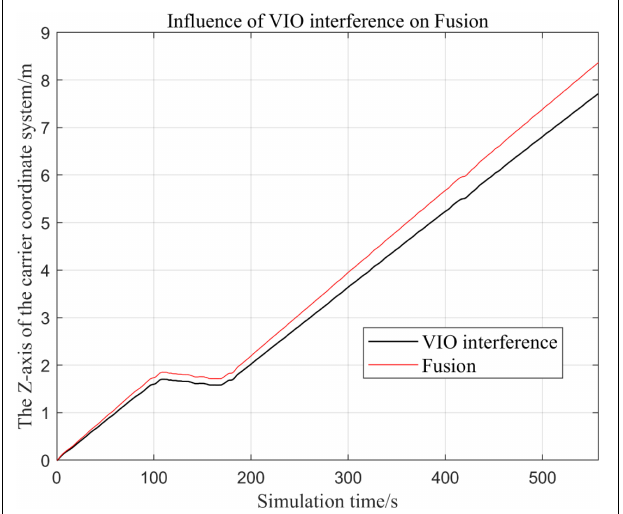
TABLE 1 | Average of absolute value of errors in x, y, and z directions.